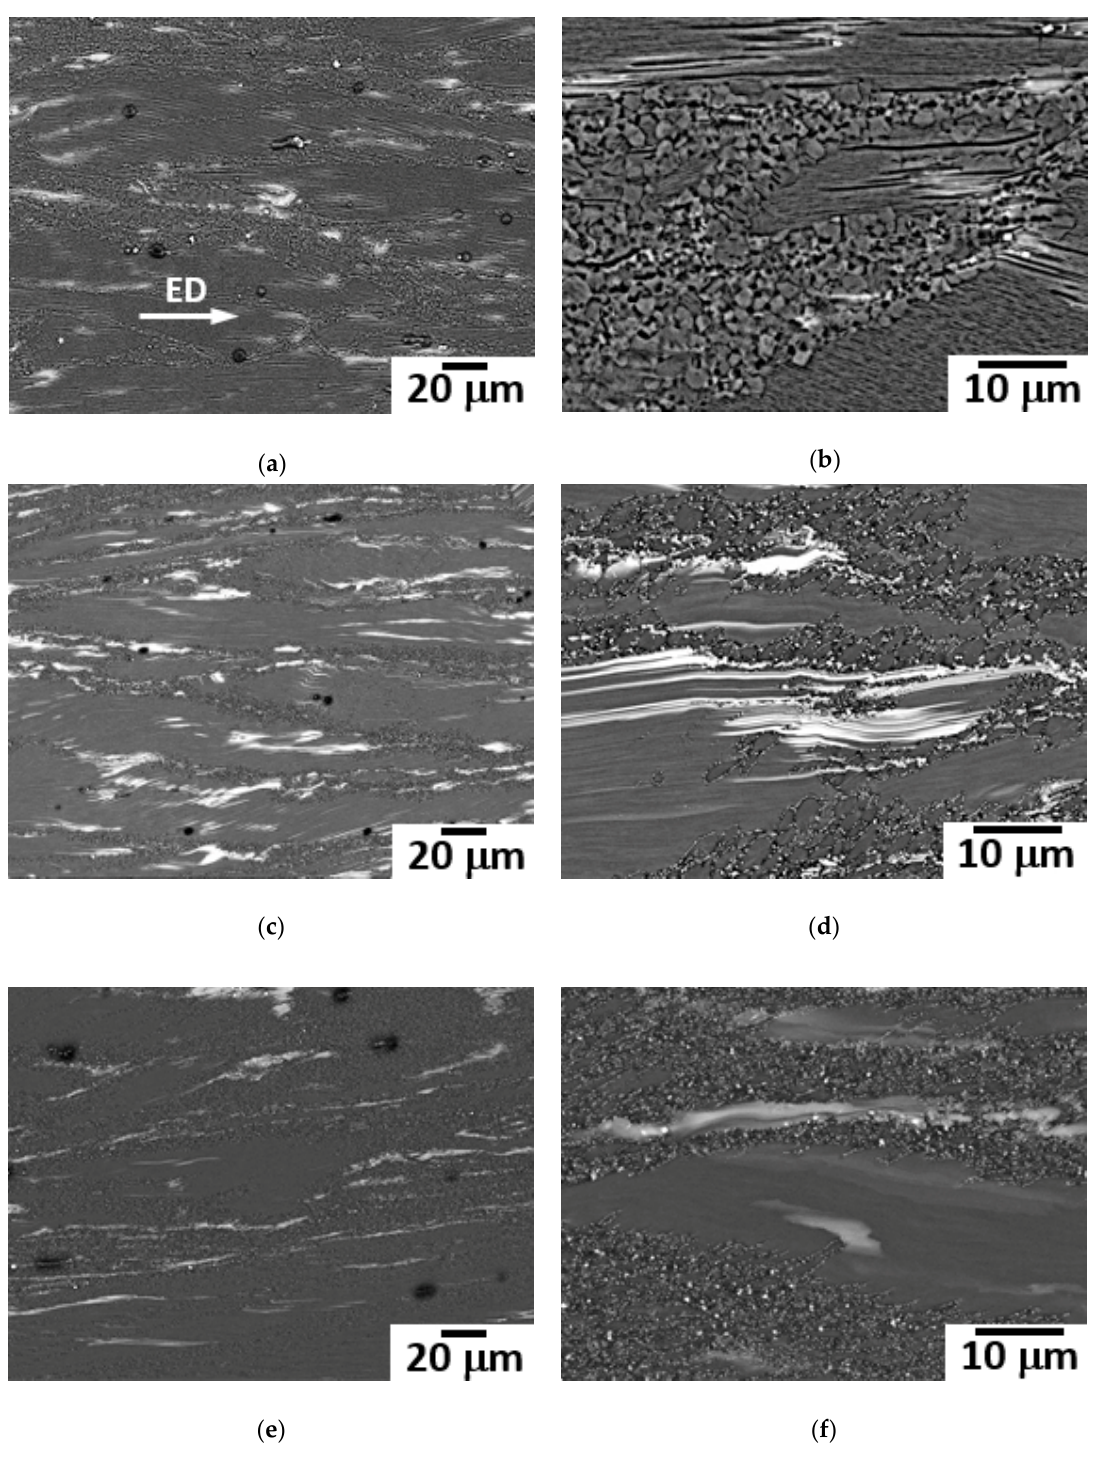
Figure 2. T Back-scattered image of the extruded GWZ31 alloy along the extrusion or ECAP directions after ( a , b ) 0, ( c , d ) 4, and ( e , f ) 6 ECAP passes. (The white arrow indicates the extrusion or ECAP direction).